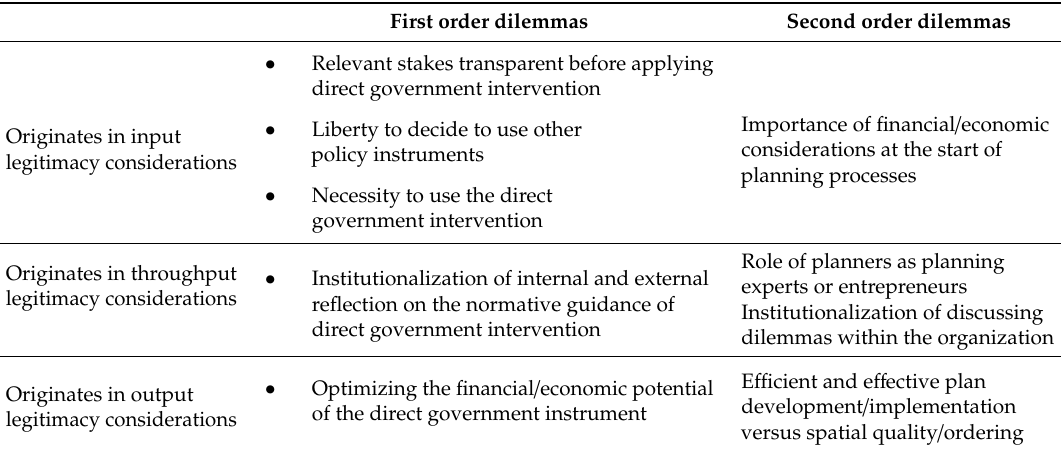
Table 1. Summary of legitimacy